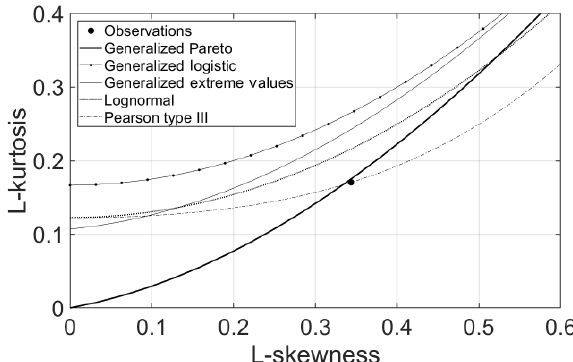
Figure 4. Exponential (EXP) probability plot of empirical and fitted cumulative distribution functions of daily rainfall depths collected at the Gioi Cilento weather